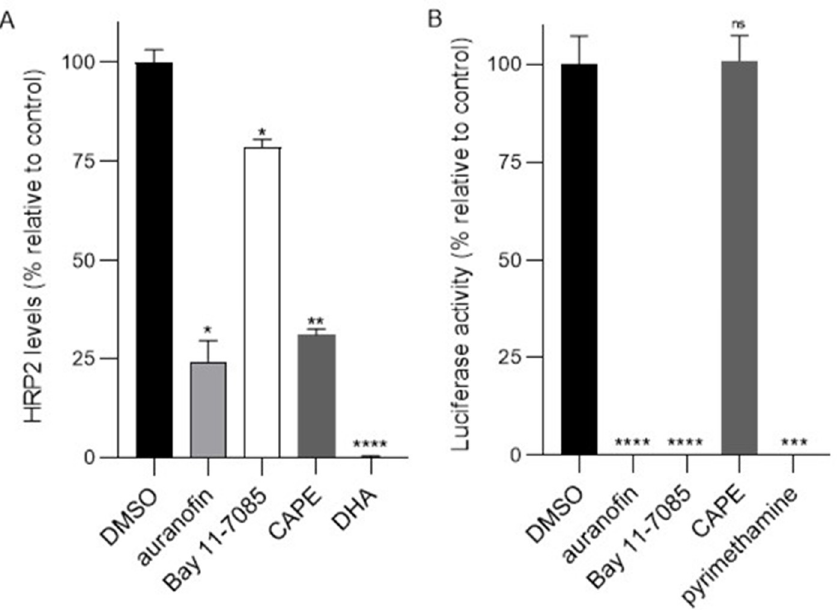
Figure 5. Results for the initial screening of selected hit compounds for antimalarial activity towards P. falciparum ( A ) and T. gondii ( B ). ( A ) P. falciparum cultures (0.25% parasitemia) were treated with 10 µ M concentration of the indicated compounds for 72 h, after which the HRP2-based sandwich ELISA was used to measure the HRP2 levels determined by optical density. Results are from a single typical experiment performed in duplicate (SD shown), representative of a series of three independent experiments. *, p < 0.05; **, p < 0.01; ****, p < 0.0001. ( B ) HFF cells infected with RH-Fluc T. gondii parasites were incubated with 10 µ M c of the indicated compounds for 48 h, after which parasite growth was measured using a luciferase assay. Results are from a single typical experiment performed in duplicate (SD shown), representative of a series of three independent experiments. ***, p < 0.001; ****, p < 0.0001; ns, not significant.